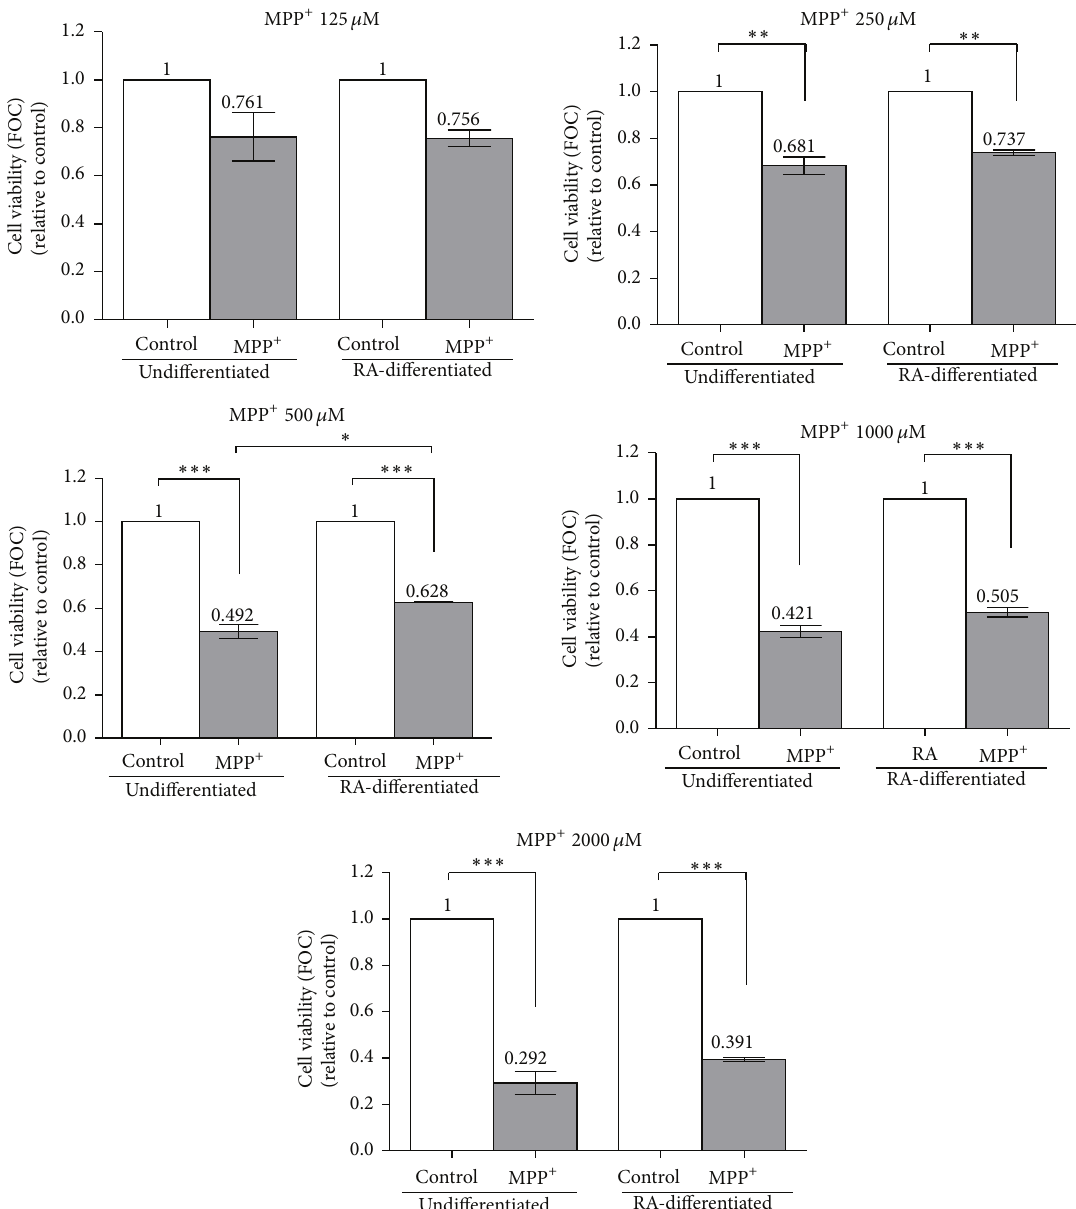
Figure 3: Effect of MPP + on cell viability of undifferentiated and differentiated SH-SY5Y cells. Cells were differentiated in 10- 𝜇 M retinoic acid (RA) for 3 days. Undifferentiated and RA-differentiated cells were plated at the same time and exposed to 125, 250, 500, 1000, and 2000 𝜇 M of MPP + for 24 hours. Cell viability was examined using MTT assay. Data are expressed as fold of changes (FOC; mean ± SEM), relative to control ( 𝑛 = 3 ). ∗ 𝑃 < 0.05 ; ∗∗ 𝑃 < 0.01 ; and ∗∗∗ 𝑃 < 0.001